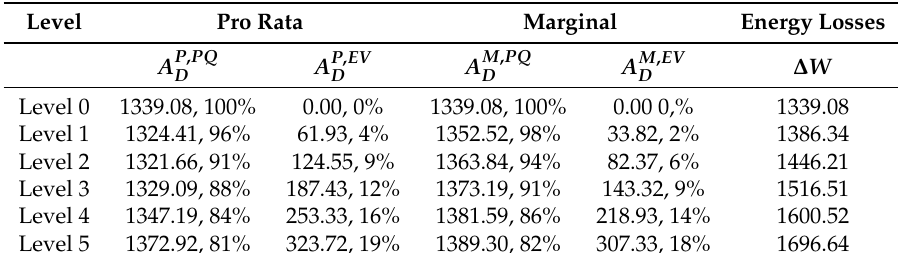
Table 3. Off-peak load scenario: total energy losses allocated to PQ and EV loads by EV penetration level (kW · h/day).